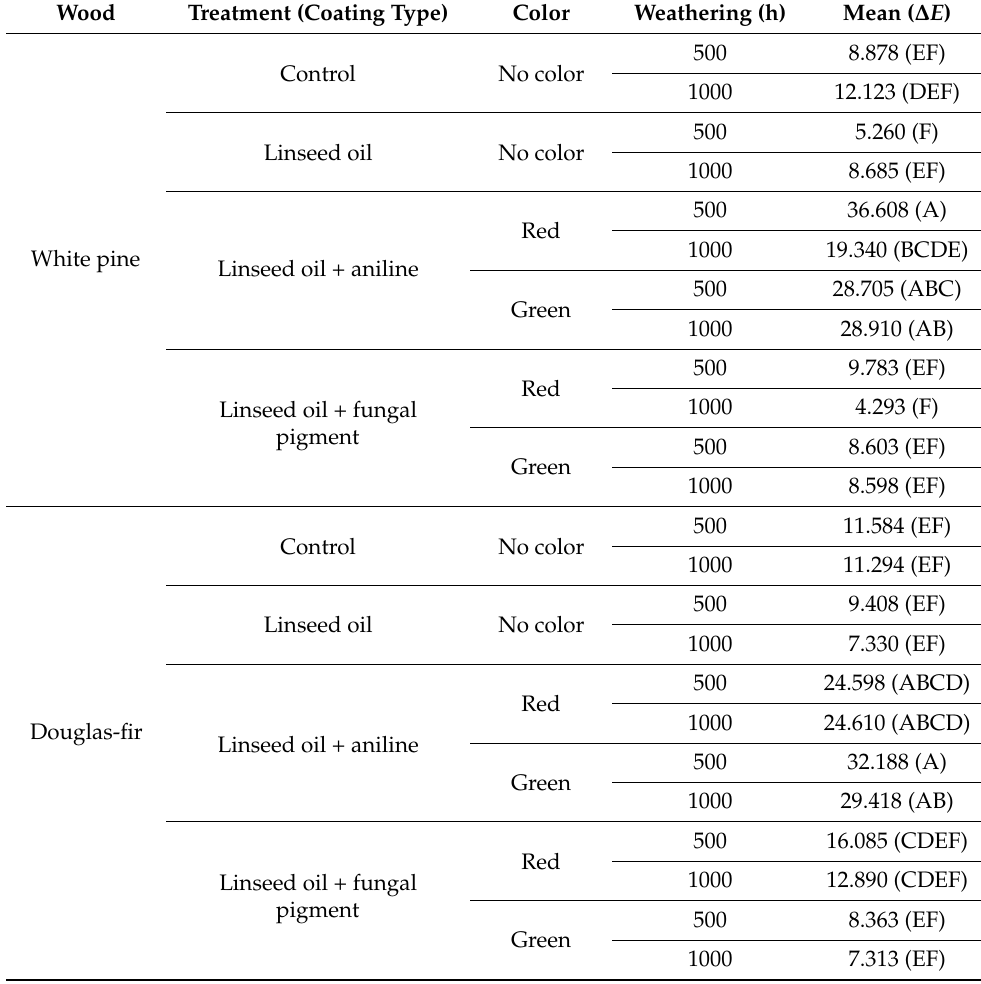
Table 1. Results for color difference after weathering ( p < 0.0001). The table Tukey groups were generated based on treatment only, as it was the only variable that showed statistical